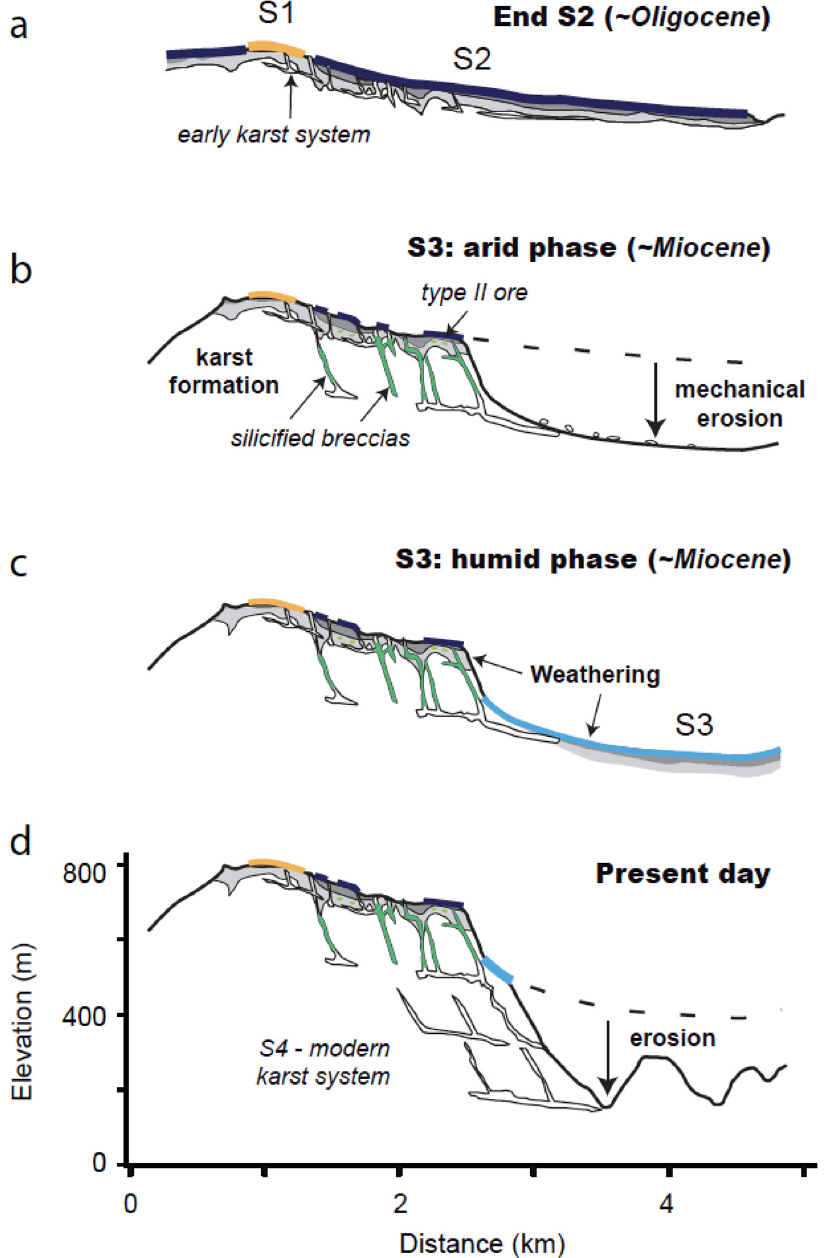
Figure 11. Conceptual model of the pseudo-karst development at Koniambo, with the paleosurface formation following the valley ʹ s deepening and progress in the erosion of the uplifted ophiolite.( a ) Formation of the paleosurface S2 at the expense of S1, and initiation of the early karst system, ( b ) Deepening of the valley, and karst silici fi cation during arid periods, ( c ) Formation of S3 related to humid periods, ( d ) Present day relief and karst.